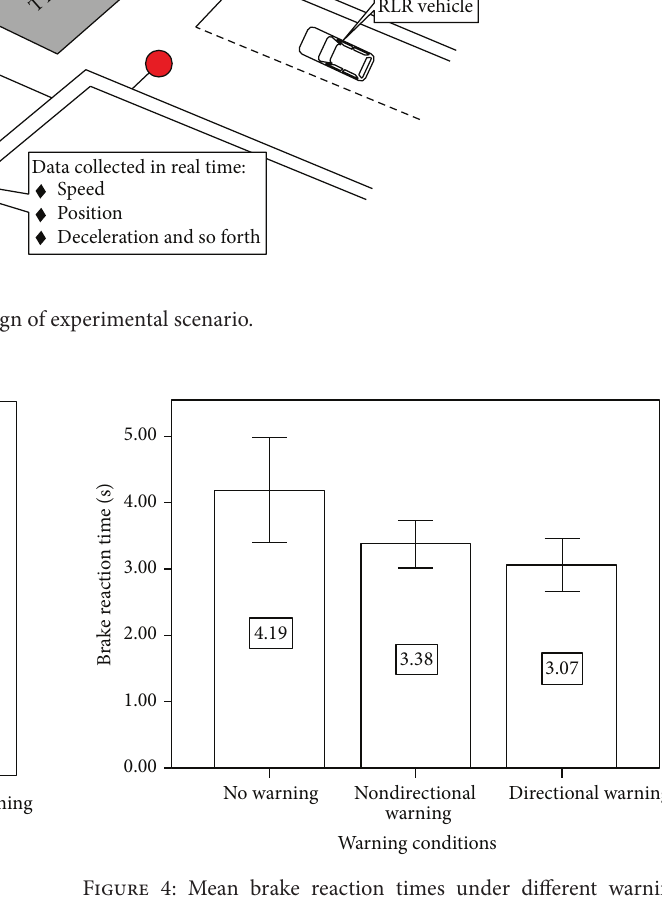
Figure 3: Crash rates under different warning conditions. Figure 4: Mean brake reaction times under different warning conditions.